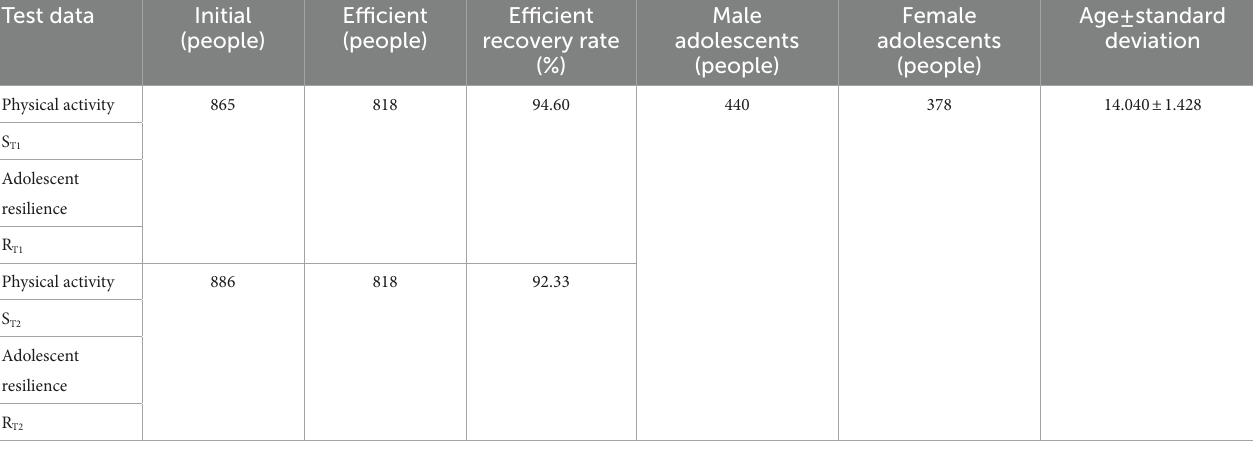
TABLE 2 Reliability and validity test analysis indicators of physical activity and adolescent